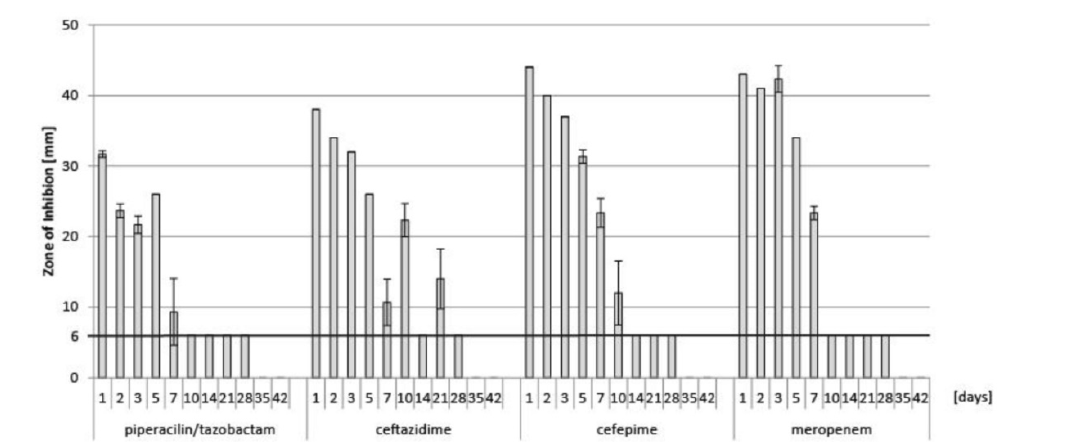
Figure 1. Results from determination of concentration of piperacillin/tazobactam, ceftazidime, cefepime and meropenem by HPLC-MS, presented as means from triplicates, with error bars indicating standard deviations.